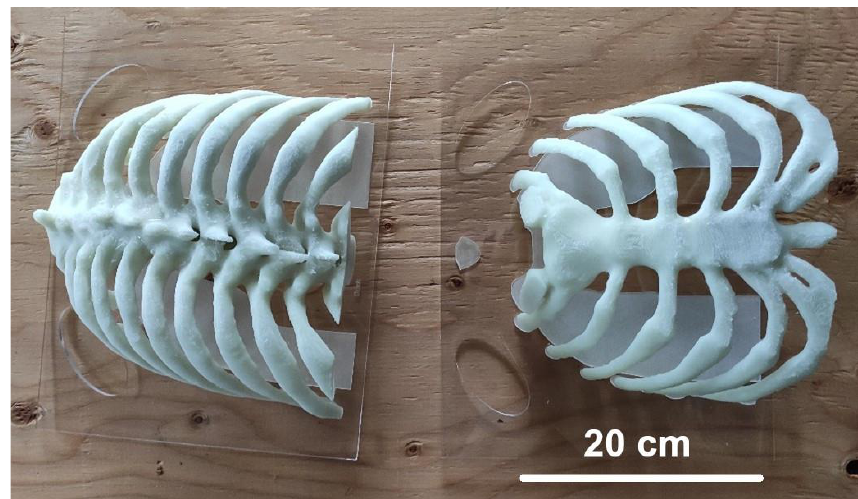
Figure 8. The printed PLA ribcage sections after assembly and sanding for the Casper phantom. They are mounted to laser-cut alignment guides.